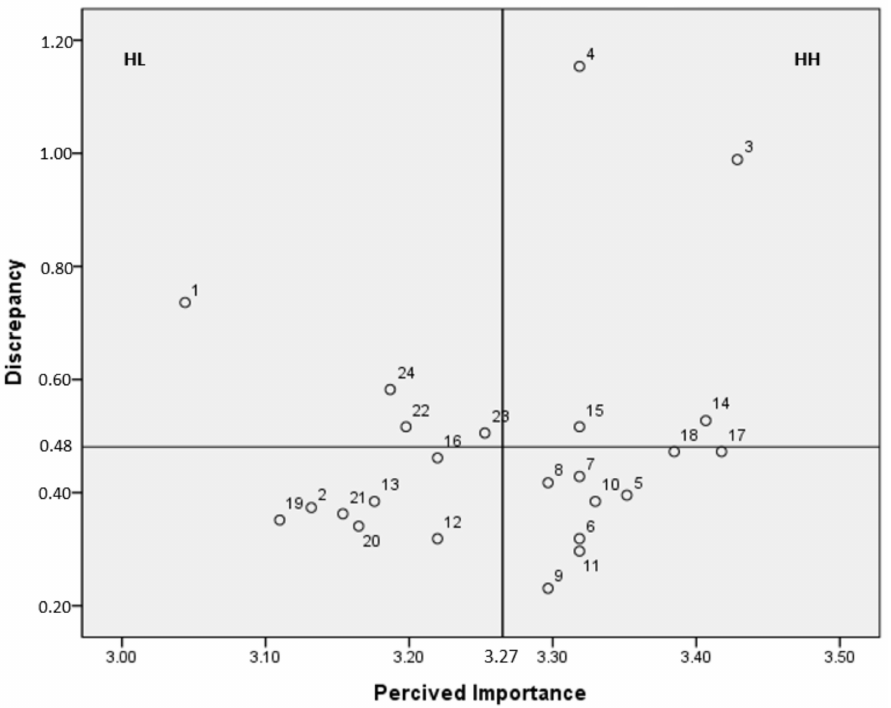
Figure 1. Visualization of priority of forest healing instructors’ educational needs for forest healing programs for cancer survivors using the Locus for Focus Model. Refer to the Table 3 for items 1 to 24.